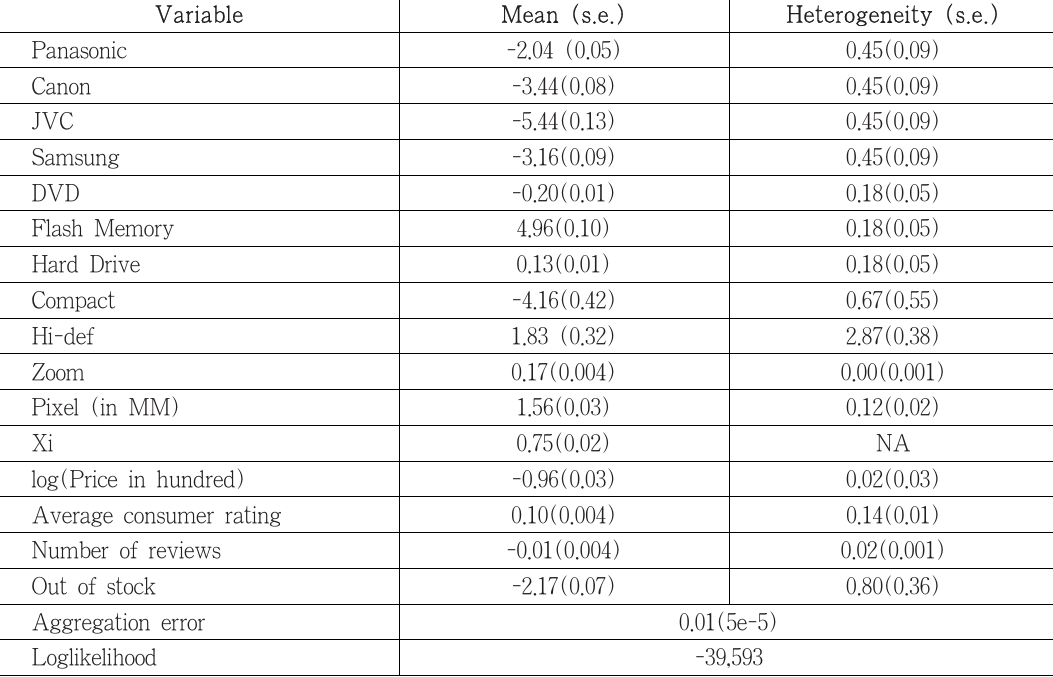
<Table 2> Estimated model parameters. For model parsimony, all brands share one heterogeneity parameter and all media formats also share another heterogeneity